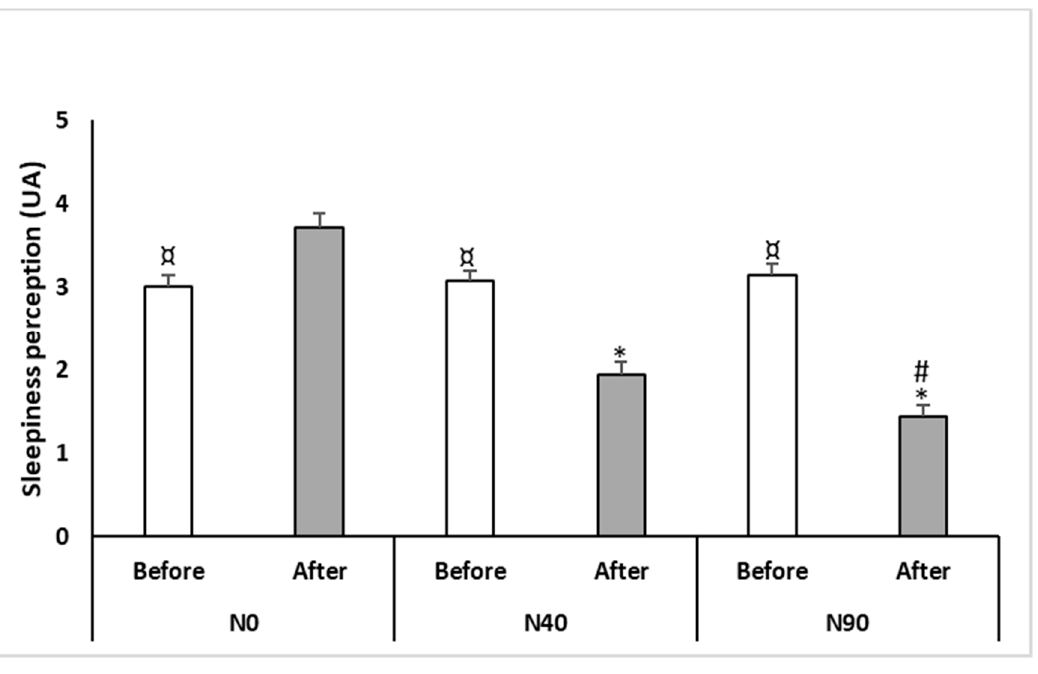
Figure 1. Perception of sleepiness was recorded before and after the 40 ‐ min (N40) and the 90 ‐ min (N90) of nap opportunities and the no ‐ nap condition (N0). ¤ Significant difference compared to after the time of each condition; * Significant difference compared to the N0; # Significant difference compared to N40.